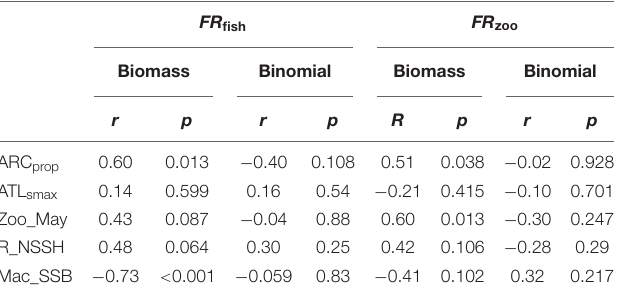
TABLE 1 | Metrics of Spearman’s correlations (r-rank correlation coefficient and p -value) between post-smolt feeding ratios and environmental variables for the Norwegian